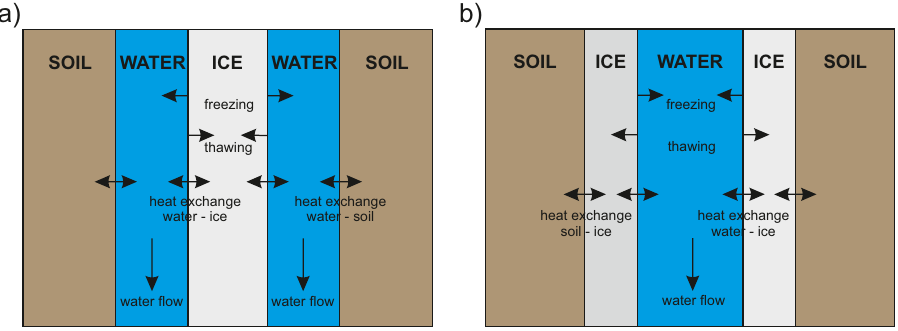
Figure 4. Schematic of different freezing behaviour in micropores ( a ) and macropores ( b ), and the resulting different hydraulic flow and heat transfer mechanisms. In micropores, ice starts to grow from the inside, while in macropores, water can freeze at the walls during